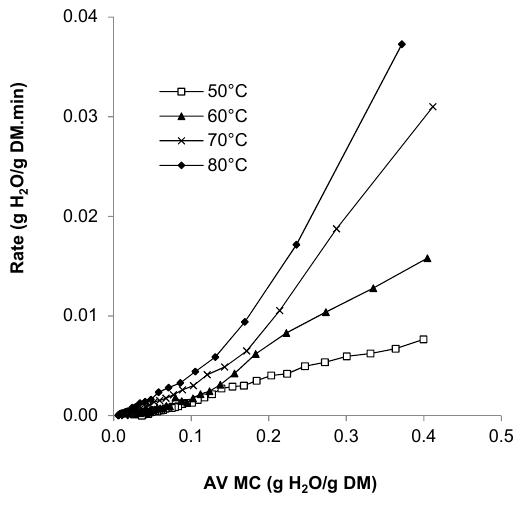
Figure 3. Effect of temperature on drying rate of dried pumpkin seeds, at an air velocity of 2.87 m/s. Initial drying rates for seeds dried at 50, 60, 70, and 80 °C averaged 0.008, 0.016, 0.031, and 0.037